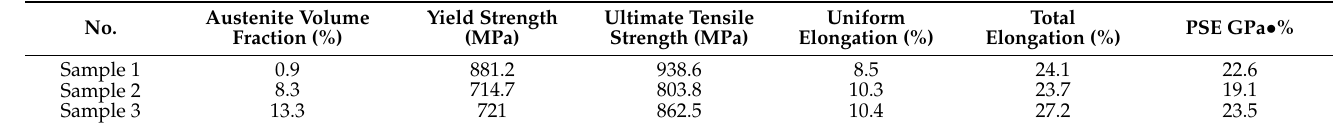
Figure 6. ( a ) The tensile engineering stress – strain curves; ( b ) strain hardening rate curves; ( c ) The value extracted from tensile curves; ( d – f ) inverse pole figure of martensitic; ( g ) volume fraction of reversed austenite obtained via putting off, interruption at 10% strain and unstrained, respectively. Table 2. The austenite volume fraction and mechanical properties of samples 1, 2 and 3.